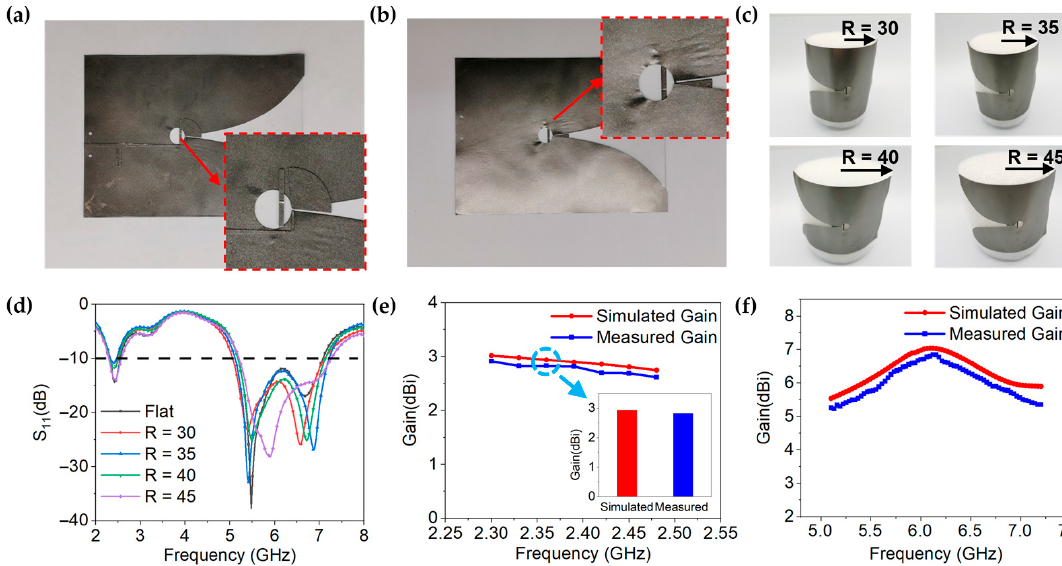
Figure 4. ( a , b ) Digital photos of the GAF dual-band antenna. ( a ) Top view. ( b ) Bottom view. ( c ) Digital photos of conformal antenna under different bending angles. ( d ) Measured reflection coefficients of the GAF antenna under different bending states. ( e , f ) Simulated and measured realized gain of the GAF antenna.